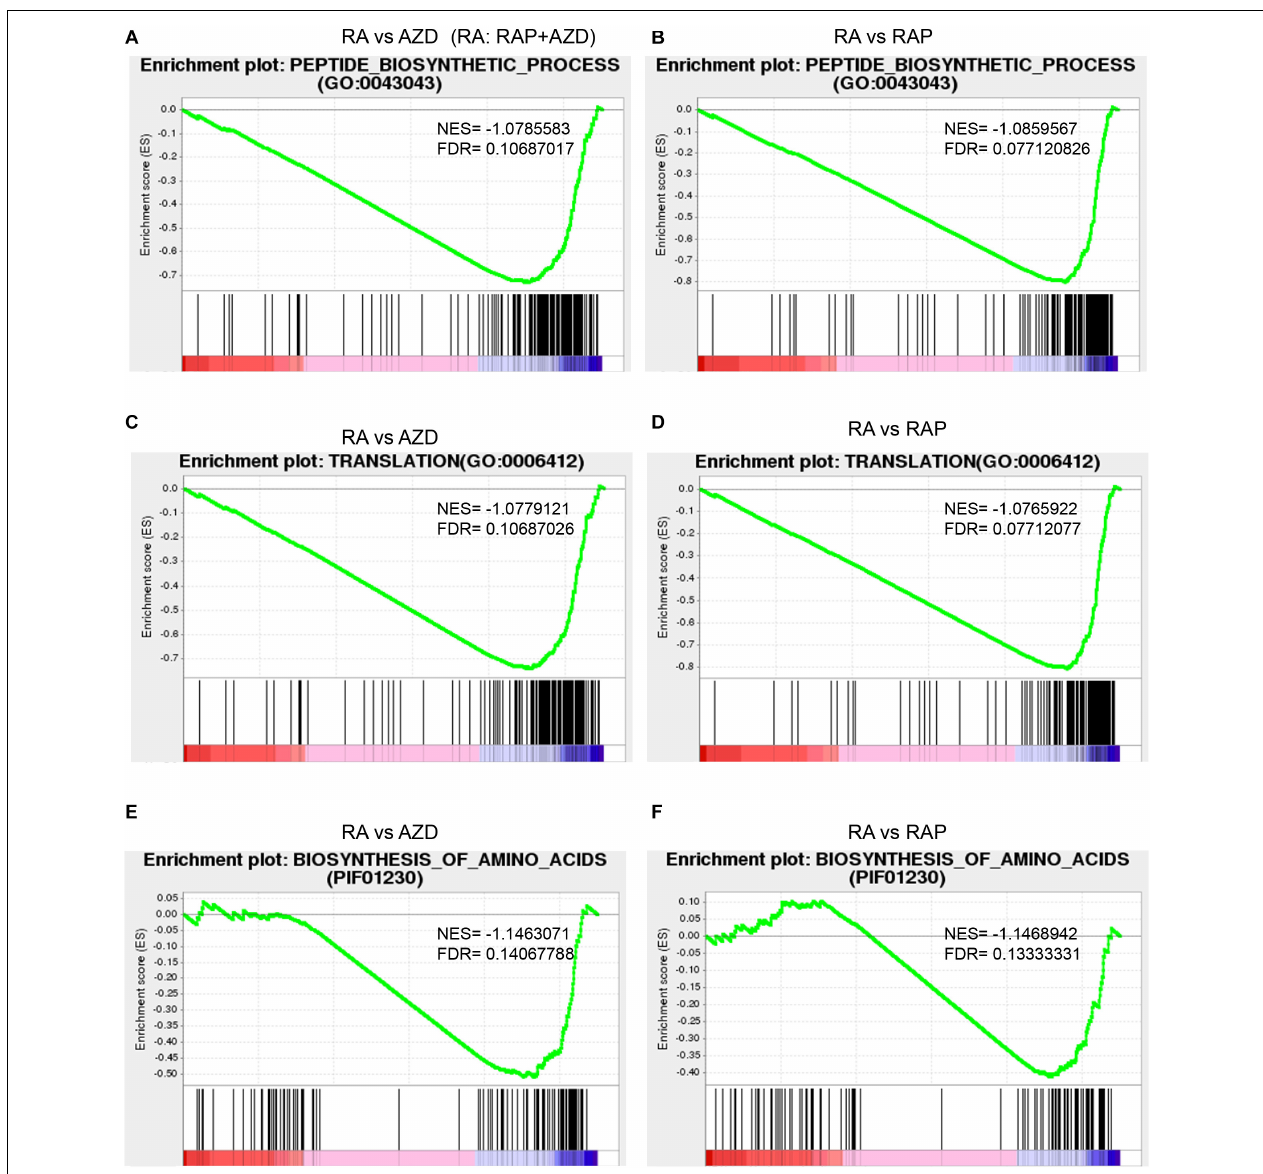
FIGURE 9 | Synergistic effects of RAP + AZD on downstream functions and processes of TOR signaling pathways. The detailed GSEA analyses of genesets in RAP + AZD vs RAP, RAP + AZD vs AZD for the peptide biosynthetic process ( A and B ), translation ( C and D ), and the biosynthesis of amino acids ( E and F ). NES, normalized enrichment score. FDR, false discovery rate. Negative (–) and Positive (+) NES indicate down-regulated and up-regulated expression in RAP + AZD,